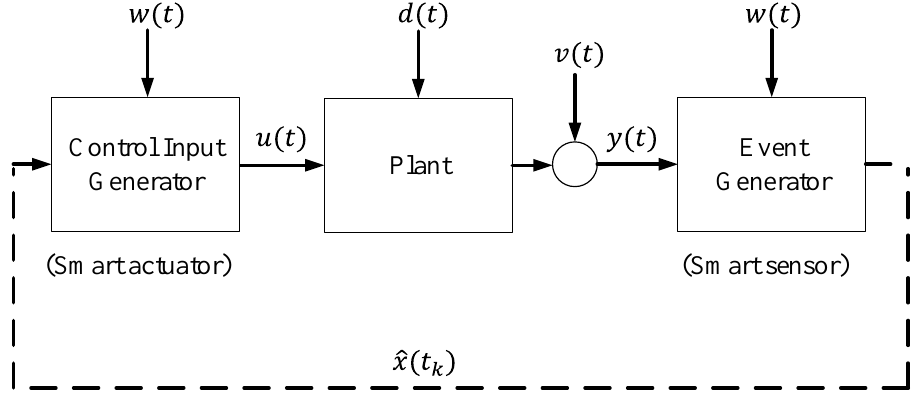
Figure 1. General scheme of an event-based control